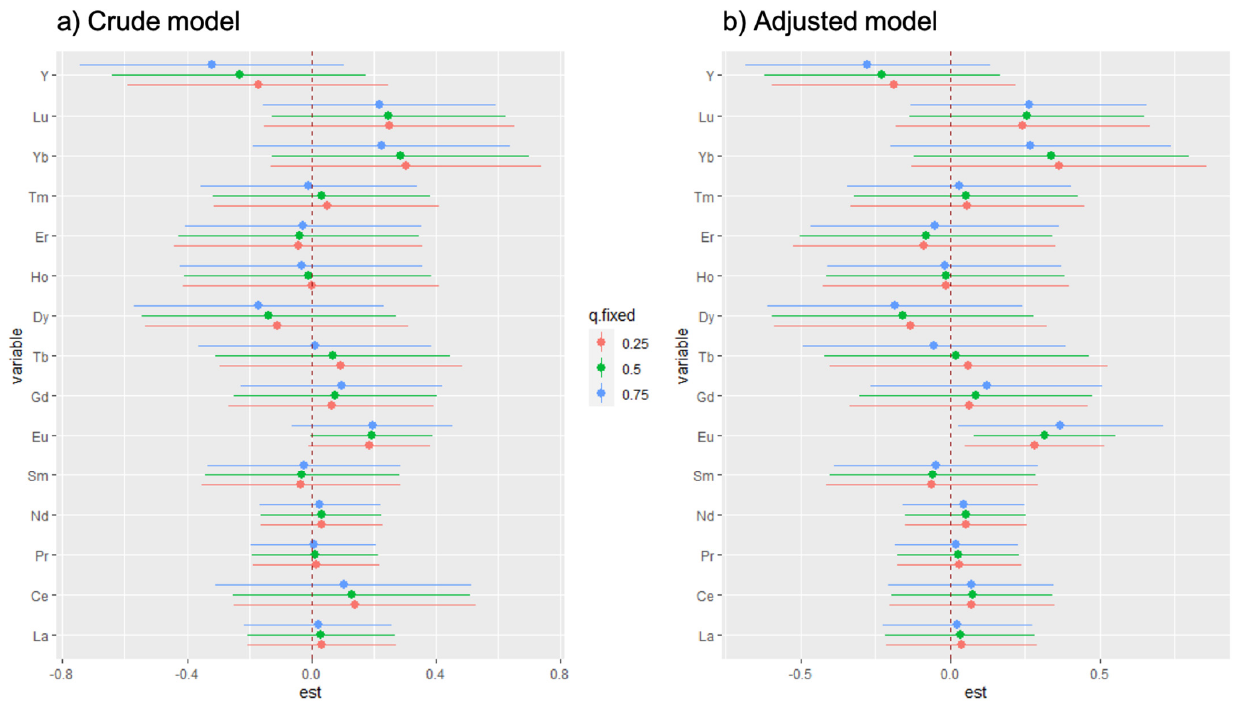
Figure 3. Single-exposure effect of 15 REEs in the BKMR model. ( a , b ) showed the contribution of certain REEs for the mixture exposure in the crude model and the adjusted model, respectively. ( a ) did not indicate any significant single-exposure effects; however, after adjusting the covariates, ( b ) presented that Eu made an important contribution in the mixture exposure.